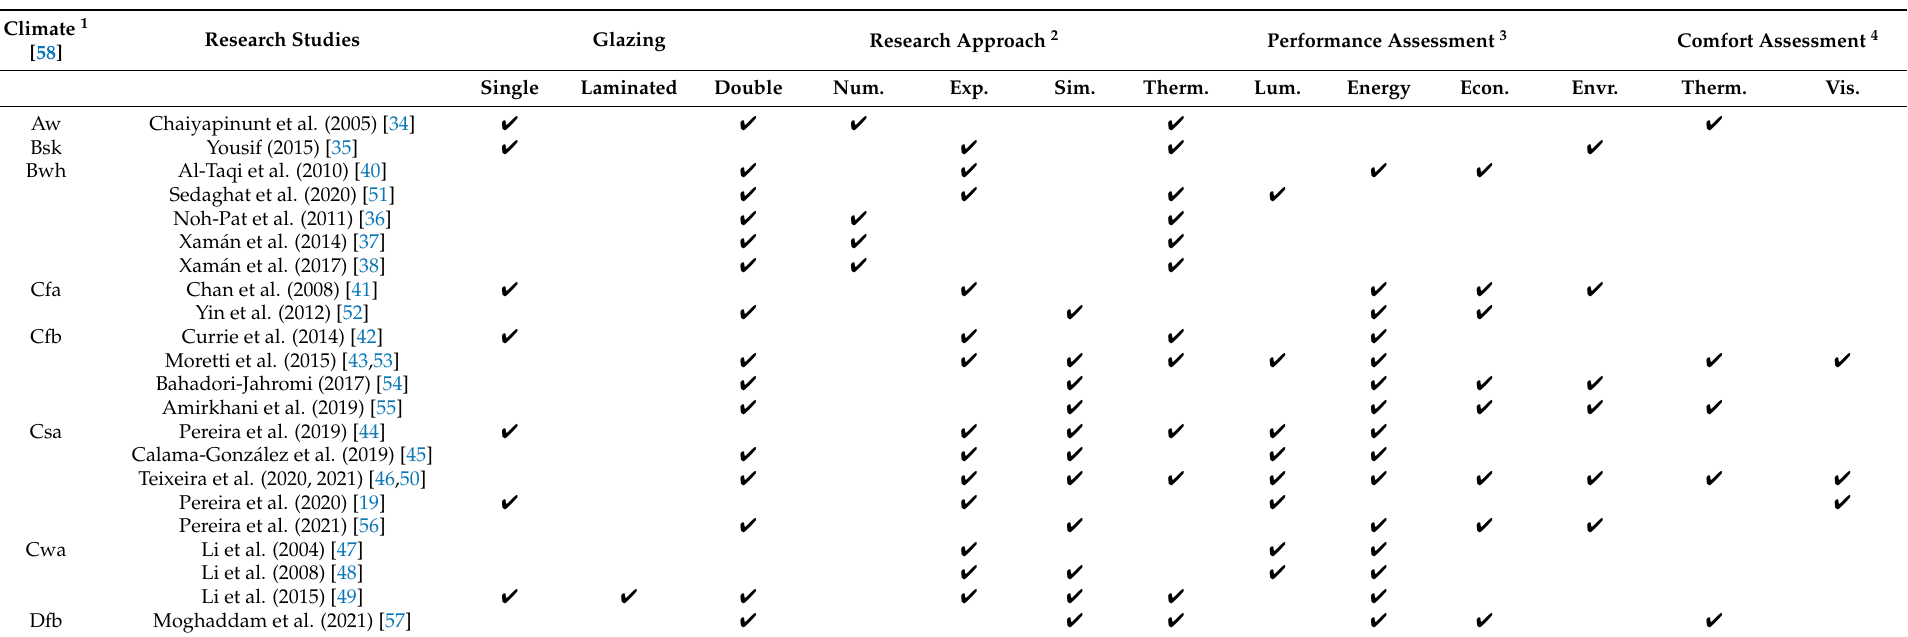
Table 2. Brief description of the type of approach and performance assessment of existing studies on the performance of solar control films. Climate 1